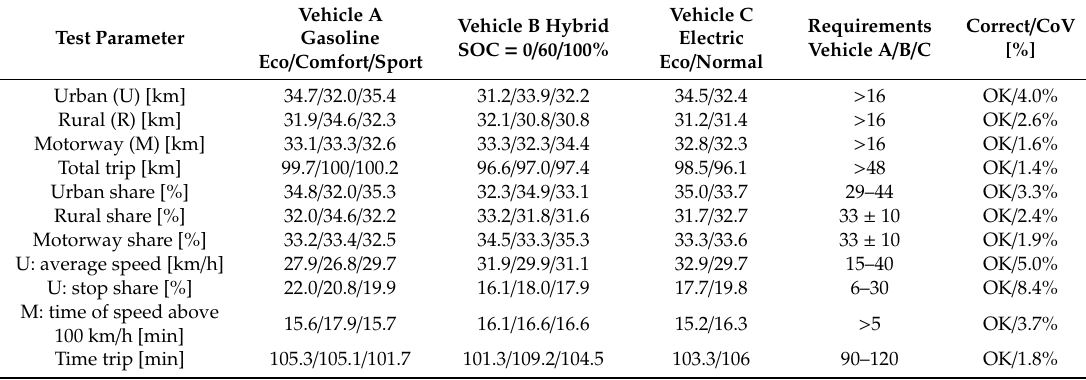
Table 2. Test route parameters along with the description of the criteria fulfillment and determination of the coe ffi cient of variation (CoV), representing the variability of the road conditions during the tests (for each vehicle the results have been specified in relevant driving modes).